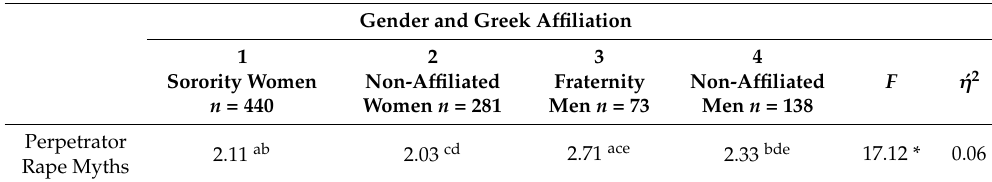
Table 2. Perpetrator rape myths as a function of gender and Greek